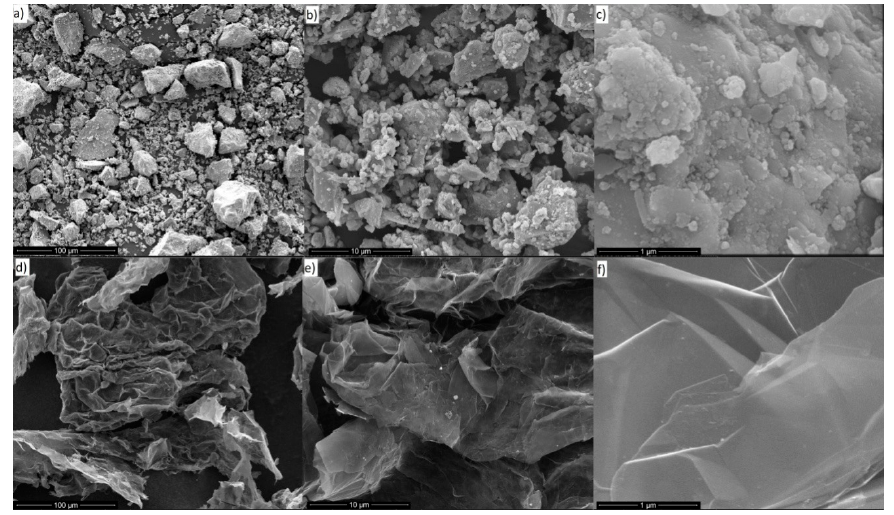
Figure 1. SEM images of: mFe 3 O 4 ( a – c ); and GNP ( d – f ), at consecutive magnifications of 100, 10 and 1 μ m.